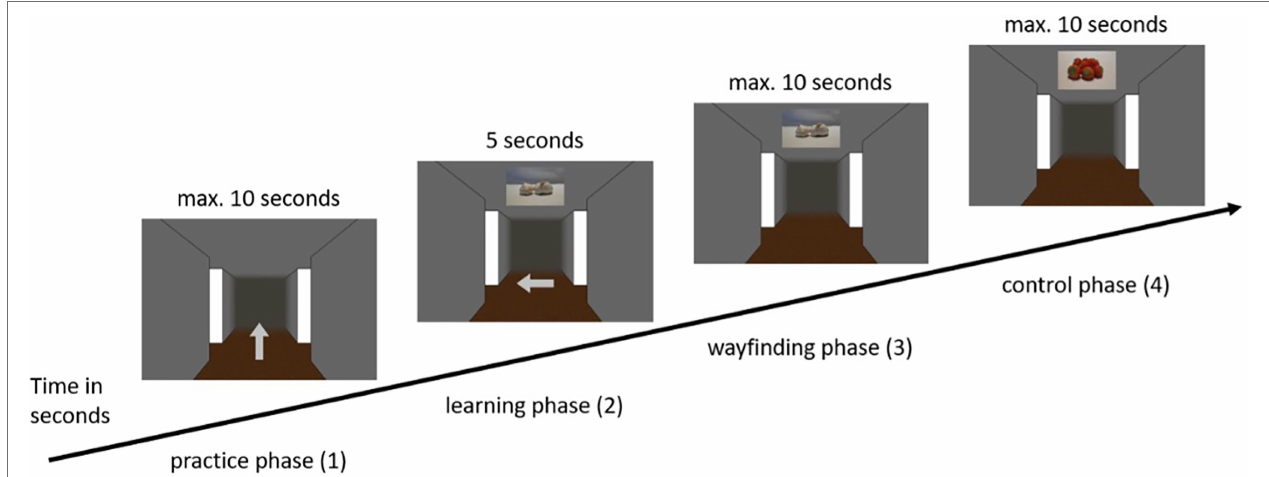
FIGURE 2 | Example sequence of the main phases of the experiment in the visual condition (visual ➔